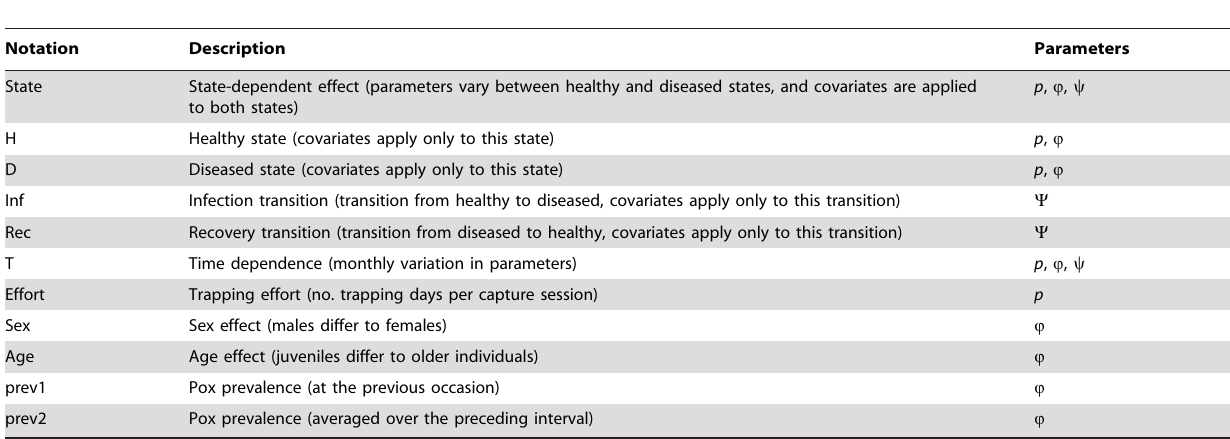
Table 1. Notation used to denote the main effects and model structure for multistate mark-recapture